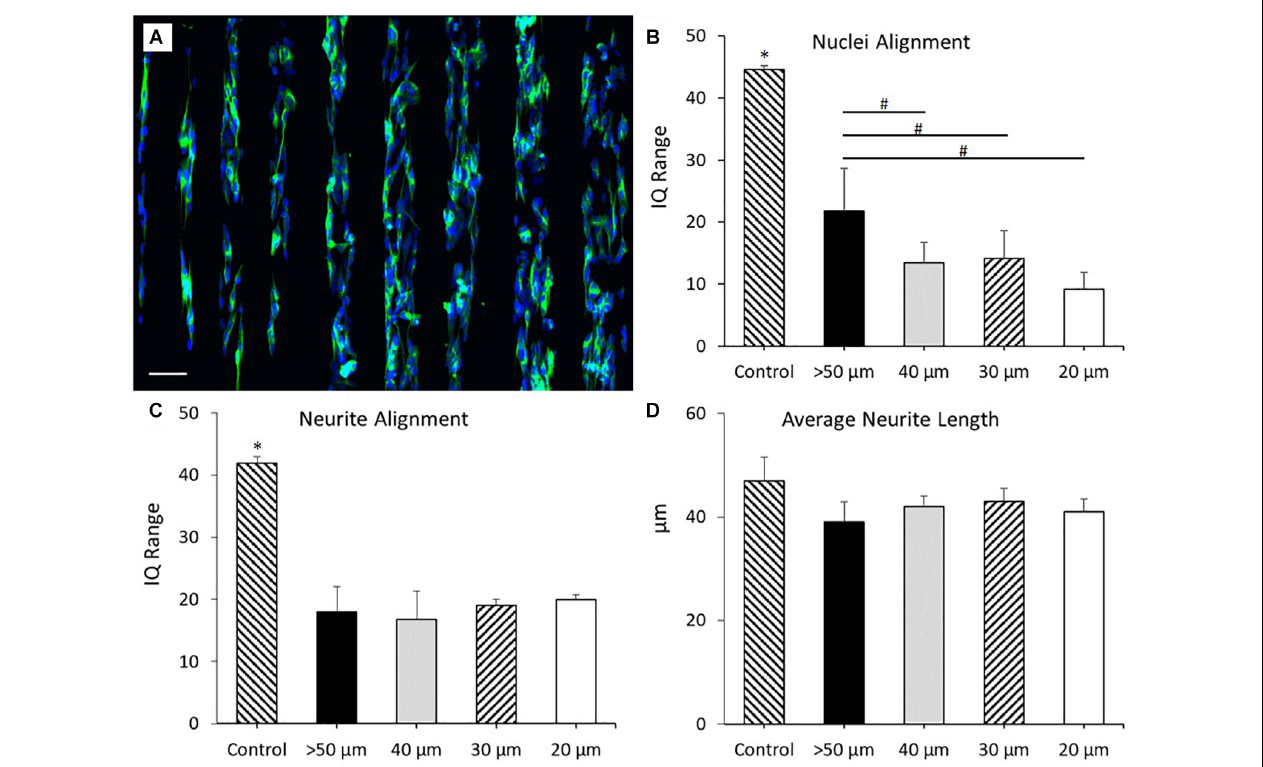
FIGURE 5 | (A) Morphological staining of SH-SY5Y neuroblastoma cells cultured on PEDOT:PSS tracks deposited via AJP onto PKSPMA coated glass substrates. Track widths ranging from 20 to 100 µ m (left to right). Green = β -tubulin, blue = DAPI. Scale bar = 100 µ m. (B) Nuclei alignment of SH-SY5Y neuroblastoma cells after 72 h in DM, cultured directly onto a PEDOT:PSS patterned PKSPMA coated glass substrate. (C) Neurite alignment of SH-SY5Y neuroblastoma cells after 72 h in DM, cultured directly onto a PEDOT:PSS patterned PKSPMA coated glass substrate. (D) Average neurite length of SH-SY5Y neuroblastoma cells after 72 h in DM, cultured directly onto a PEDOT:PSS patterned PKSPMA coated glass substrate. Control condition refers to untreated glass. Data presented as mean ± SD from n = 6 experimental repeats in each condition. # significantly different within group, ∗ significantly different from all other conditions ( P <